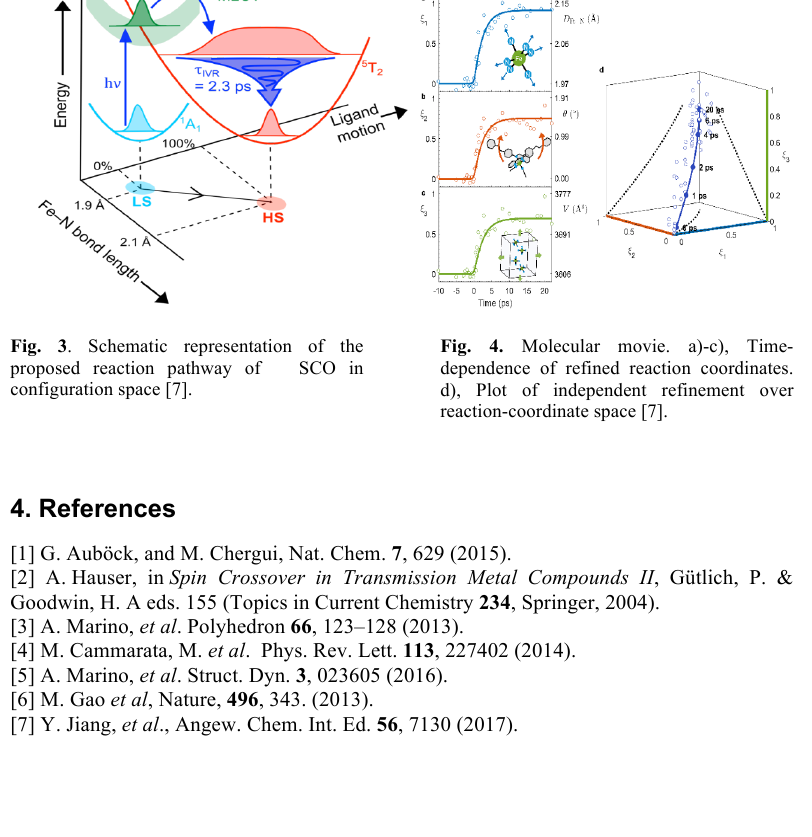
Fig. 3 . Schematic representation of the proposed reaction pathway of SCO in configuration space [7].